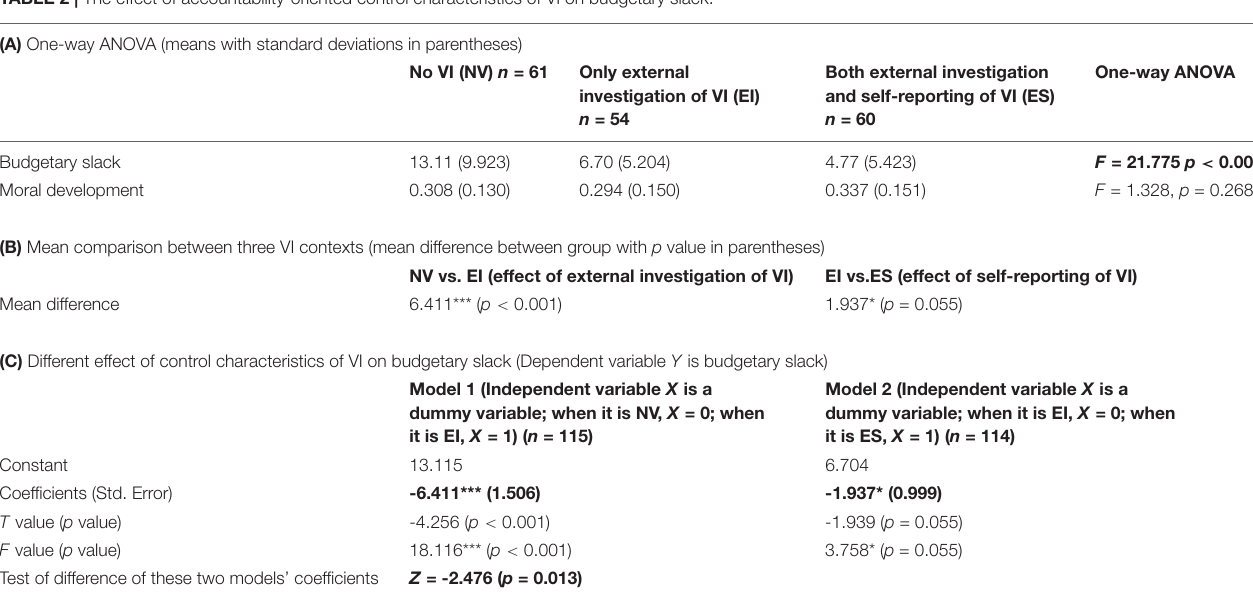
FIGURE 2 | Budgetary slack of subordinates with low and high moral development in the three different budget contexts. The participants with P scores less than 0.314 (the mean of P score of all participants) are placed in the “Low Moral Development” Group and the other participants are placed in the “High Moral Development” group. TABLE 2 | The effect of accountability-oriented control characteristics of VI on budgetary